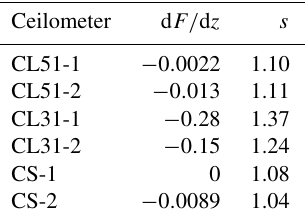
Figure 14. (a) Profile of the relative humidity (black line) in per- cent (see labels at the top) and profiles of the water vapor num- ber density (in 10 24 moleculesm − 3 , labels at the bottom) for the 06:00UTC radiosonde ascent (solid red line) and the 12:00UTC ascent (dashed red line) of 20 August 2015. The validation range is highlighted in yellow. (b) Particle transmission T p at 1064nm de- rived from the Klett inversion of averaged RALPH signals (20 Au- gust 2015, 05:00–08:00UTC, Case B) assuming a lidar ratio as in- dicated. The circles indicate the reference height. (c) Effective water vapor transmission T w , eff for different laser wavelengths λ on . Solid lines: 900nm (black), 905nm (red), 907nm (green), 910nm (blue); dashed lines: 915nm (black), 925nm (red)), analogously to Fig. 10.